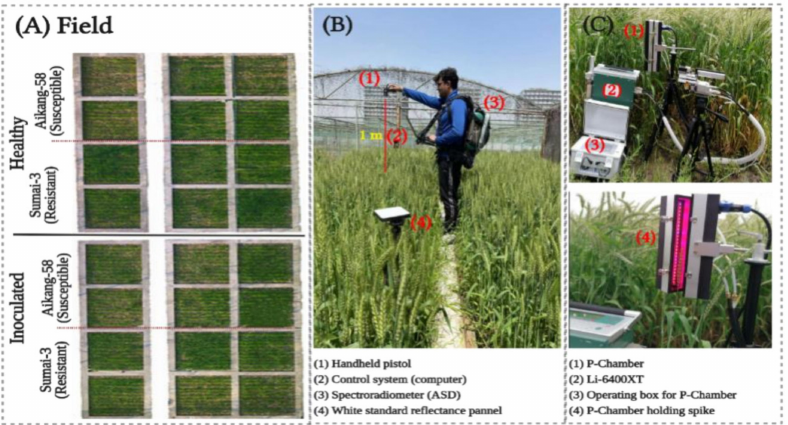
Figure 1. Illustration of applied instruments at canopy scale in field experiment: ( A ) Field view ( B ) hyperspectral reflectance data acquisition and ( C ) photosynthesis rate (Pn) measurement of wheat